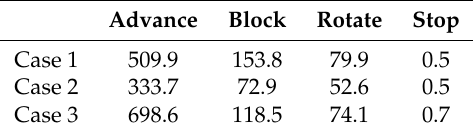
Table 10. Time elapsed in each mode (Units: